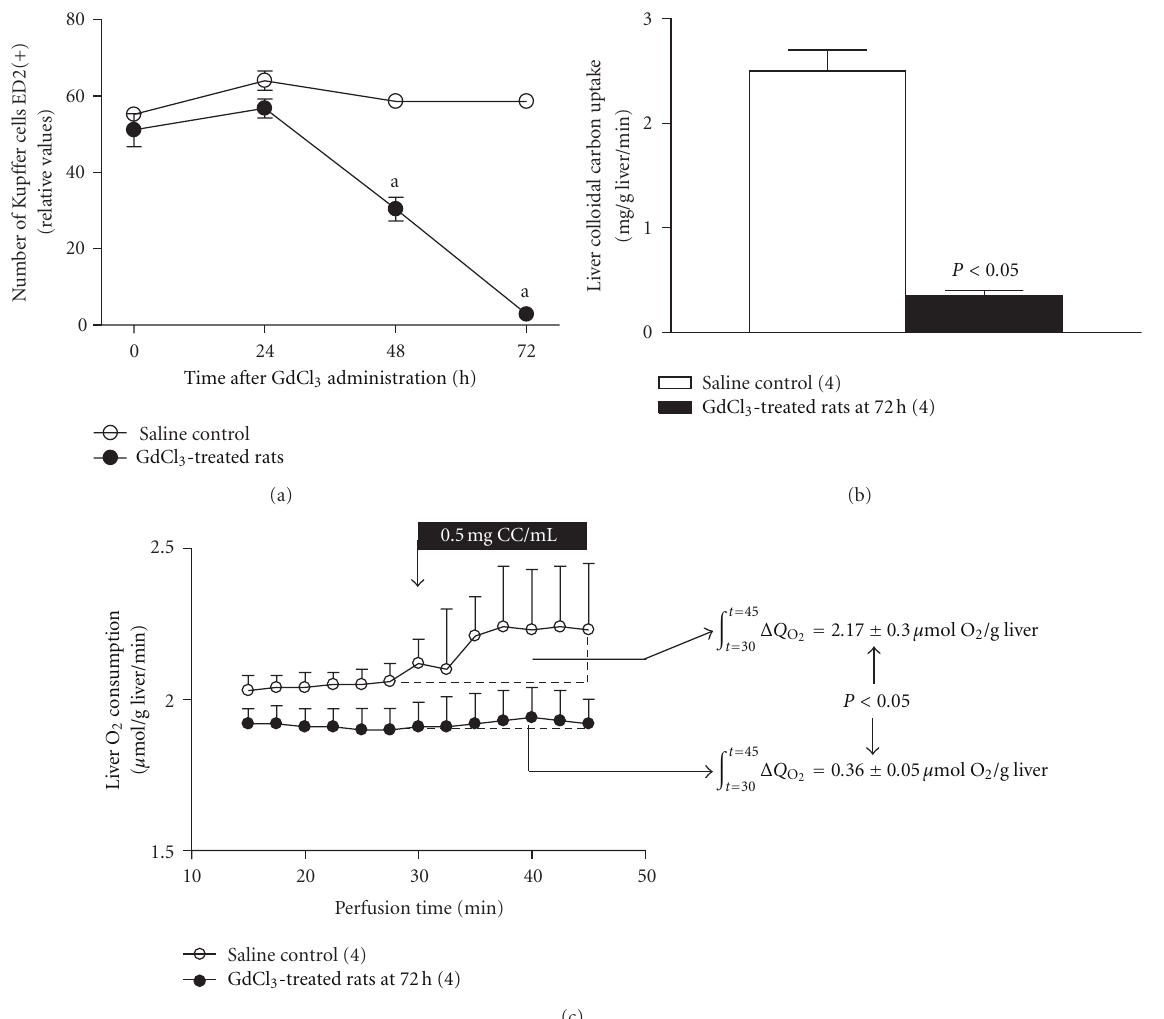
Figure 1: Gadolinium chloride (GdCl 3 ) administration is associated with suppression of Kup ff er cell functioning in rat liver. Kinetics of Kup ff er cell inactivation after GdCl 3 treatment (time zero) in livers from euthyroid rats by immunohistochemistry using ED2 antibody (a), rate of colloidal carbon uptake (b), and carbon-induced liver respiratory activity ( Δ QO 2 ) (c) assessed in isolated perfused livers at 72 h after GdCl 3 treatment. Δ QO 2 was calculated by integration of the area under the O 2 consumption curves between 30 and 45 min perfusion (c). Values shown represent means ± SEM for 4 rats per experimental group. a P < 0 . 05 versus controls assessed by Student’s t -test for unpaired